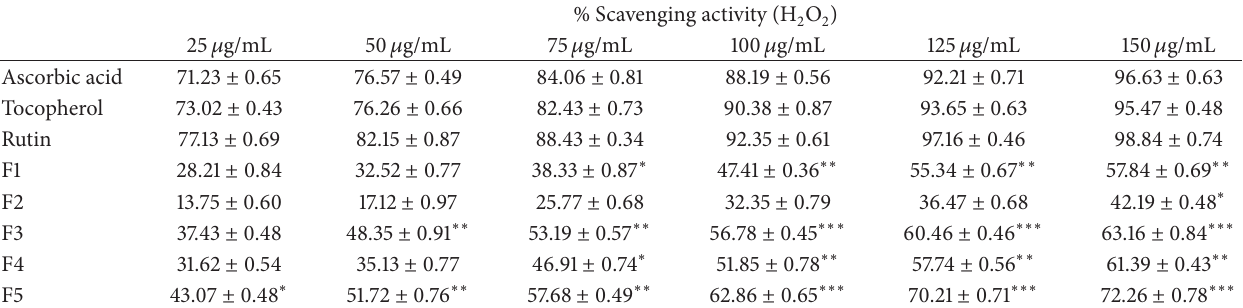
Table 4: Hydrogen peroxide radical scavenging activity of flavone